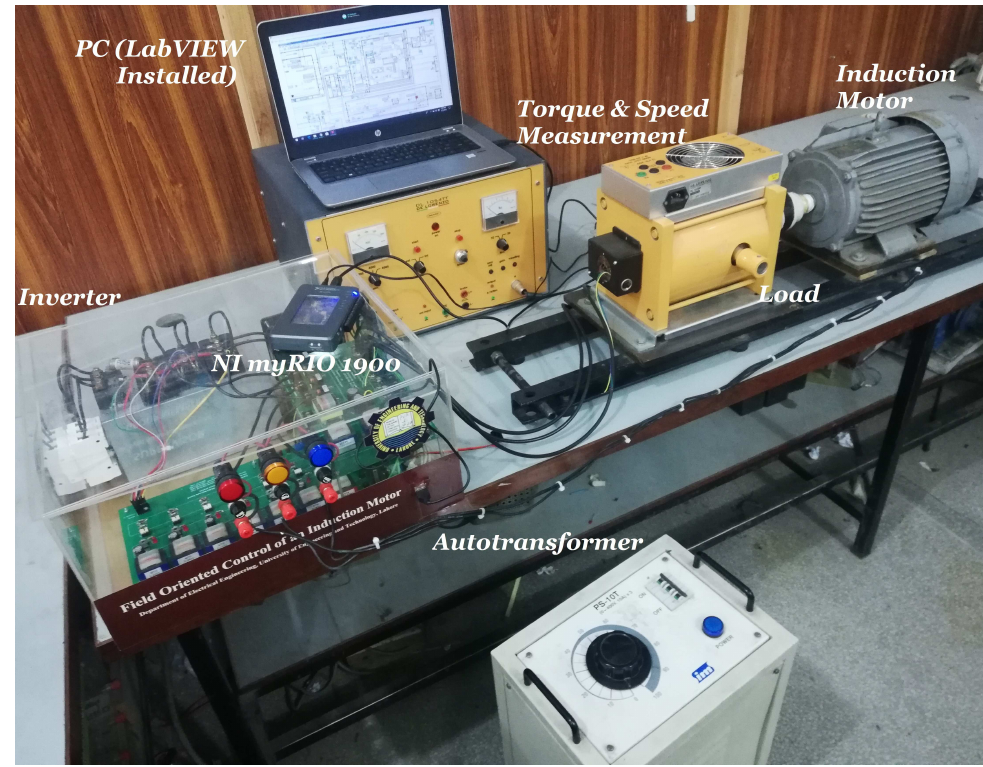
Figure 10. Induction machine drive testing